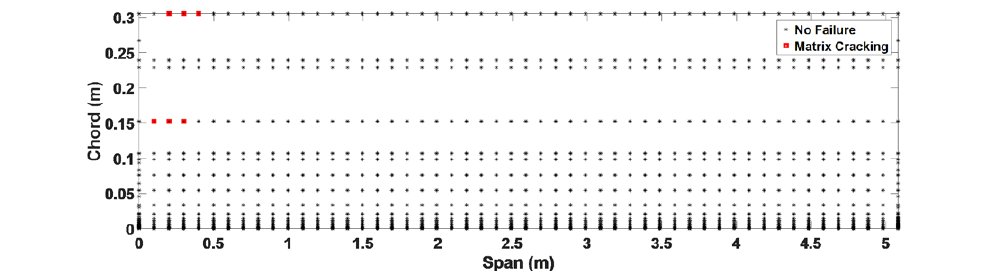
rad/secFigure 7. Fail nodes at 13